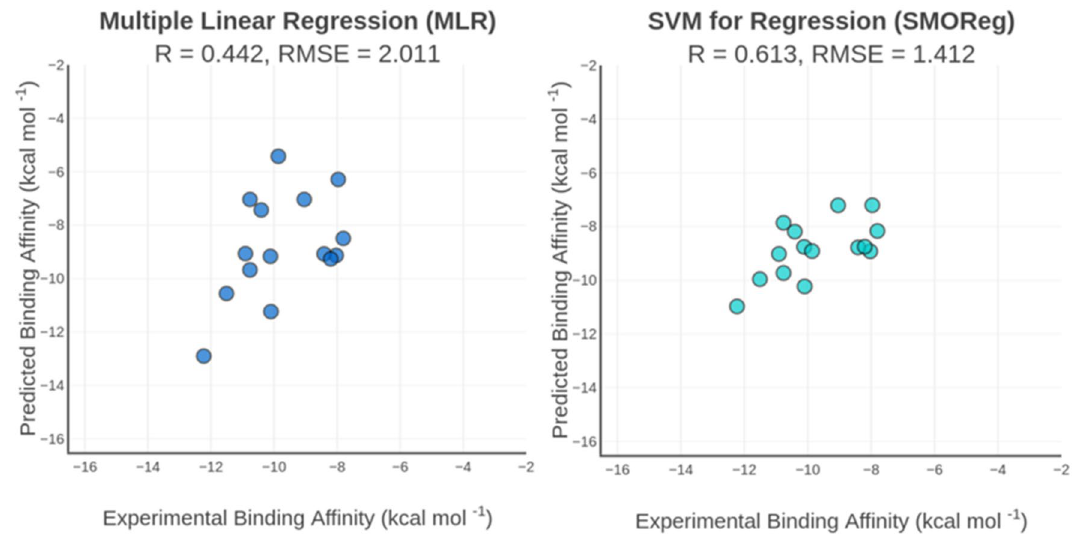
Figure 4. Correlation plot of predicted and predicted binding affinity by MLR (left) and SMOReg (right) specific scoring functions for iPPIs using one solvation term evaluated on the independent test set for iPPIs (N = 15). R is the Pearson’s correlation coefficient and RMSE is the root mean squared error given in kcal mol -1 .